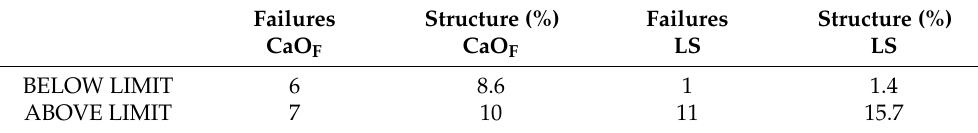
Table 6. Economic analysis—index of failures for CaO F , LS. Source: own source.